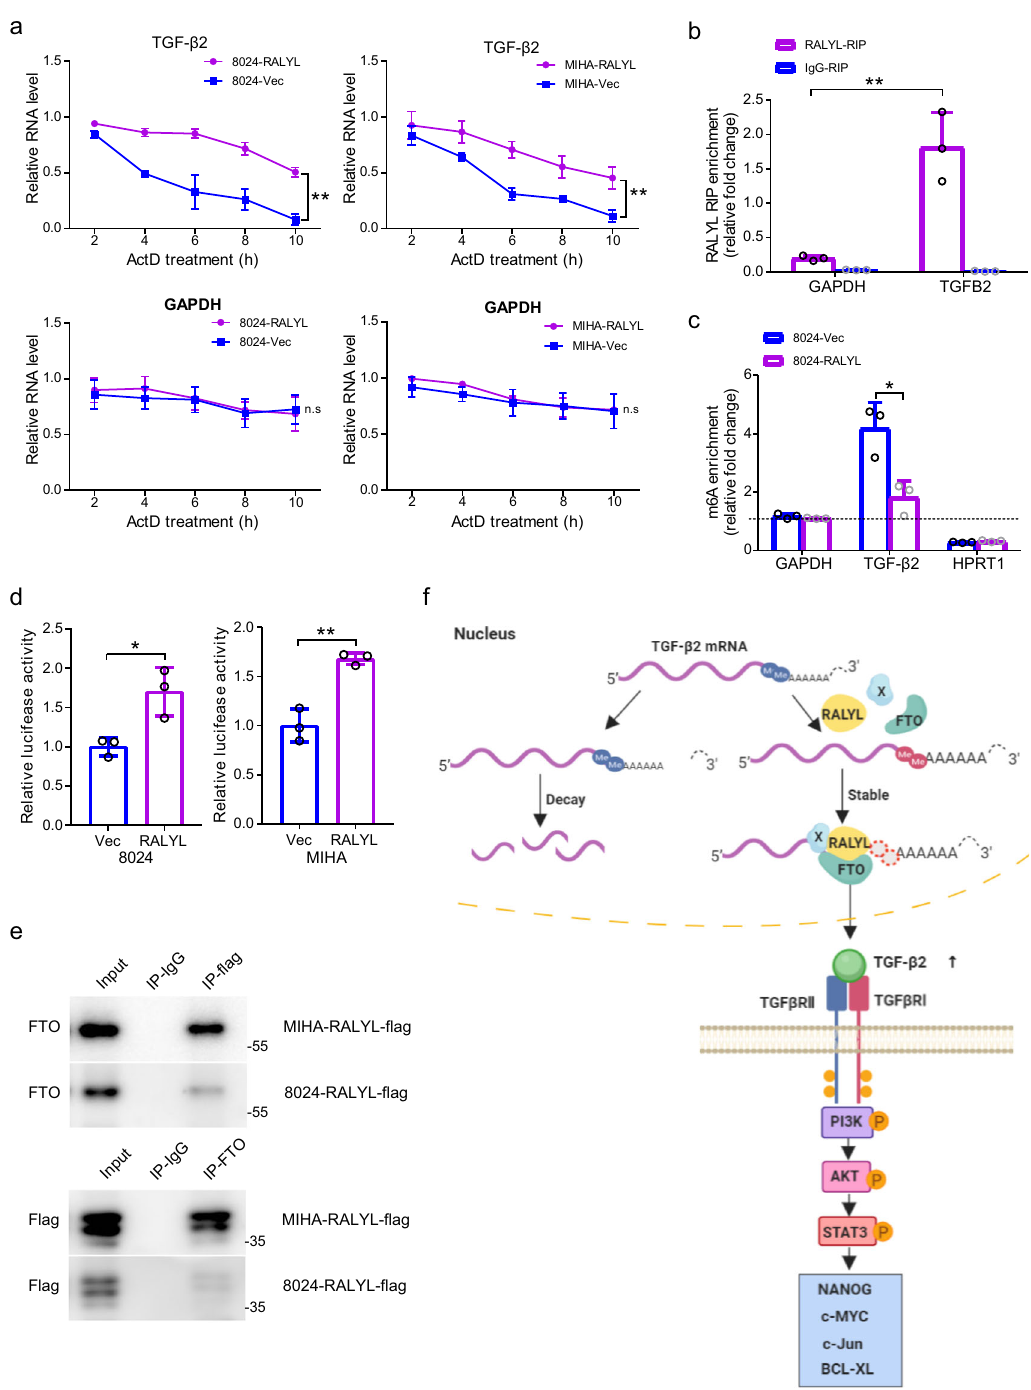
Fig. 6 RALYL upregulates TGF- β 2 mRNA stability depending on m 6 A modi fi cation. a PLC-8024 and MIHA cells were transiently transfected with Vec or RALYL plasmid for 48h and then treated with ActD for 0, 2, 4, 6, 8, 10h. The TGF- β 2 mRNA level was determined using qRT-PCR and normalized to 18S rRNA. The GAPDH mRNA level was used as a negative control. The values represent the mean ± SD of 3 independent experiments (* P <0.05, ** P <0.01, independent Student ’ s t -test). b RIP assay using total cell lysates of Huh7 cells was used to assess the interaction between RALYL and TGF- β 2 mRNA. Enrichment of TGF- β 2 mRNA in the RALYL -containing immunoprecipitated particles was measured using qRT-PCR and normalized to input. c m 6 A RIP and qRT-PCR were used to determine the percentage of TGF- β 2 mRNA with m 6 A modi fi cation in 8024-Vec and 8024- RALYL cells (* P <0.05, Student t -test). d 3 ′ UTR of TGF- β 2 mRNA was fused with fi re fl y luciferase reporter. RALYL overexpression augmented the luciferase activity in 8024 and MIHA cells. The values represent the mean ± SD of three independent experiments (* P <0.05, ** P <0.01, two-sided Student ’ s t -test). e The interaction of RALYL with FTO was determined by co- immunoprecipitation with anti-FTO (IP: FTO) and anti-FLAG antibody (IP: FLAG) or IgG (IP: IgG) in RALYL - fl ag-transfected cells. Total cell lysate (Input) was used as a positive control. f A schematic diagram illustrating the proposed RALYL enhanced stemness-related features in HCC. RALYL could decrease m 6 A modi fi cation of TGF- β 2 mRNA, thereby maintain its stability by interaction with FTO. By sustaining the secretion of TGF- β 2, the PI3K/AKT and STAT3 were activated to increase the stemness of